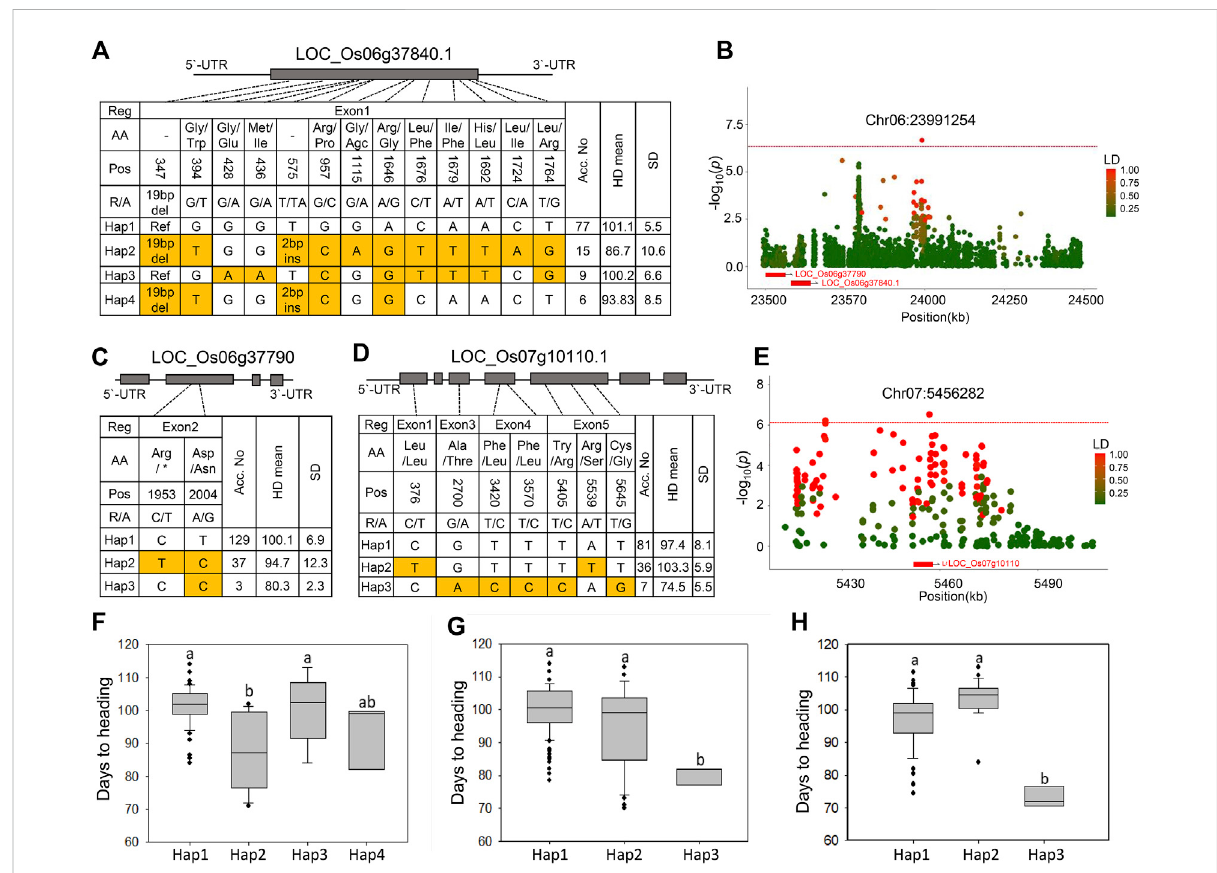
FIGURE 4 Haplotype analysis and strong association signals in chromosomes six and seven for Hd. (A) Four haplotypes were detected in LOC_Os06g37840. (B) The LD plot shows association loci for LOC_Os06g37840 and LOC_Os06g37790 at chromosome 6. The color of each SNP indicates r 2 (LD)forthecorrelationwiththeleadSNP.RedandgreencolorintensitiesindicatestrongerandweakerLD(0 – 1). (C) Twohaplotypeswere detected in LOC_Os06g37790. (D) Haplotype analysis and phenotypic differences between the HAPs of LOC_Os07g10110. (E) The LD plot shows association loci for LOC_Os07g10110 at chromosome 7. (F – H) Haplotype analysis of the LOC_Os06g37840 (F) , LOC_Os06g37790 (G) , and LOC_Os07g10110 (H) . Different letters indicate signi fi cant differences, according to Duncan ’ s multiple range test ( p <